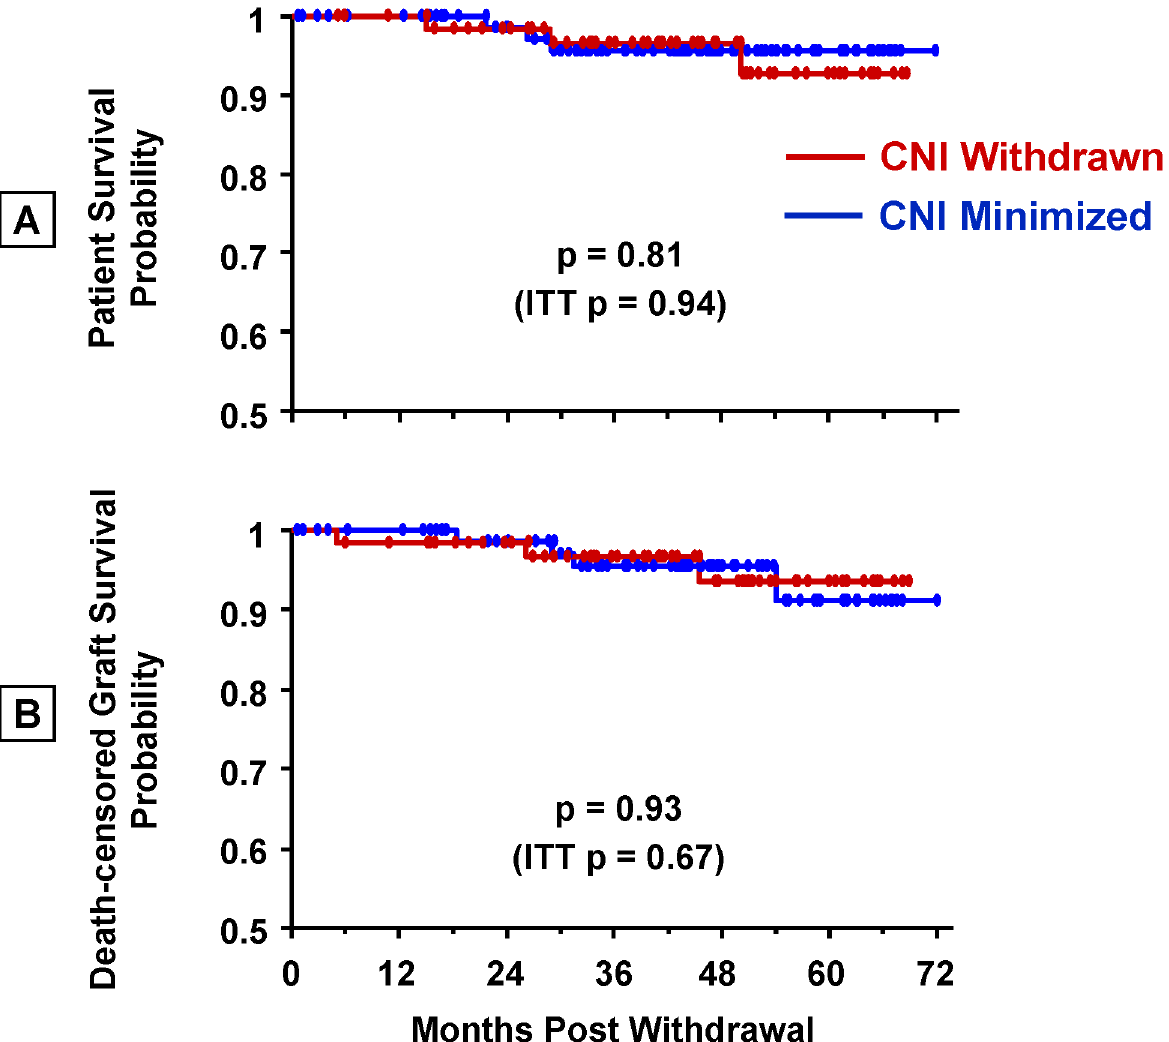
Fig 6. On-treatment patient and death-censored graft survival after CNI withdrawal. P-values for the intent-to-treat analyses are also shown.